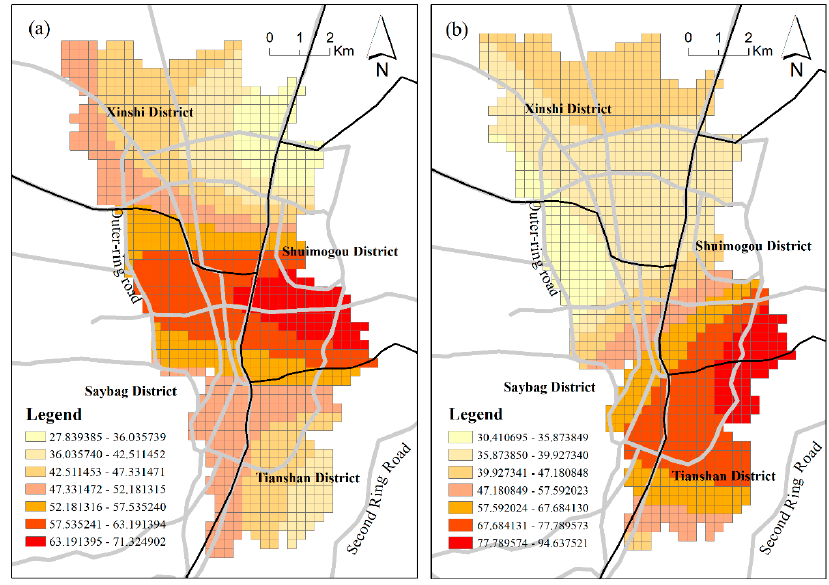
Figure 5. The coefficient of FAR: ( a ) Model 1; ( b ) Model 2.